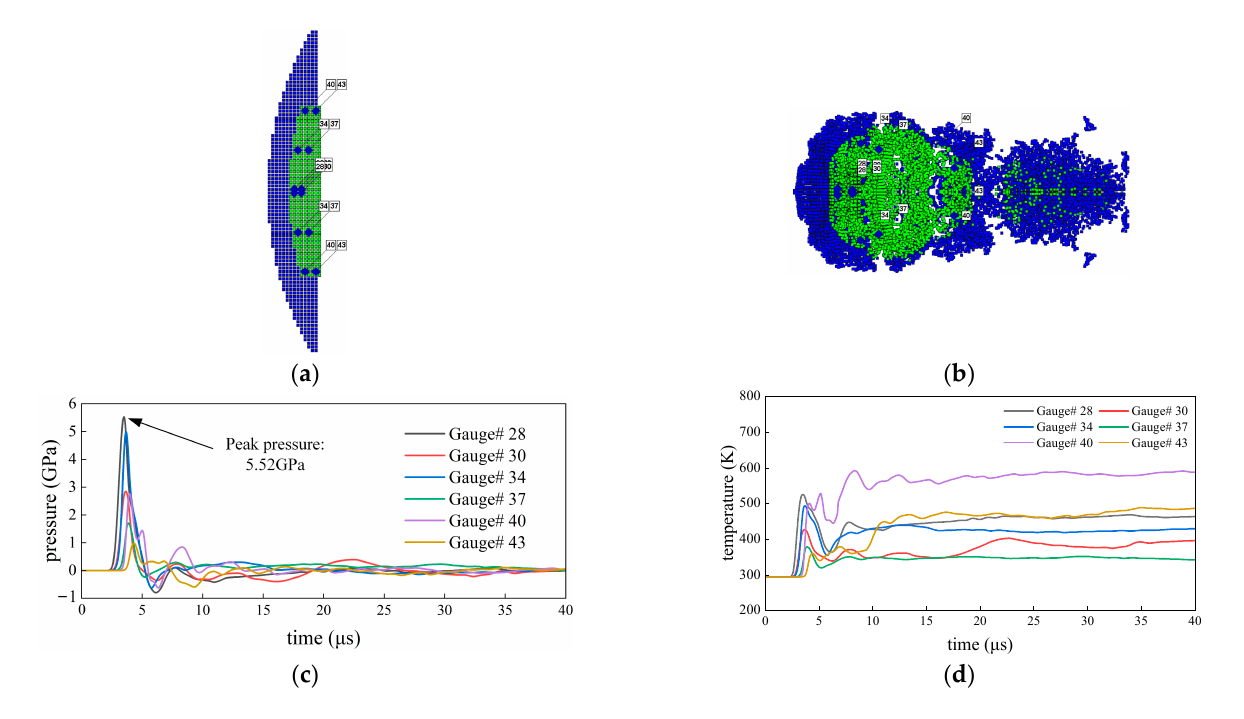
Figure 8. Typical pressure and temperature changes inside the reactive liner: ( a ) Distribution and number of gauge points setting; ( b ) t = 60 µ s distribution and number of observation points; ( c ) Pressure-time curve; ( d ) Temperature-time curve.